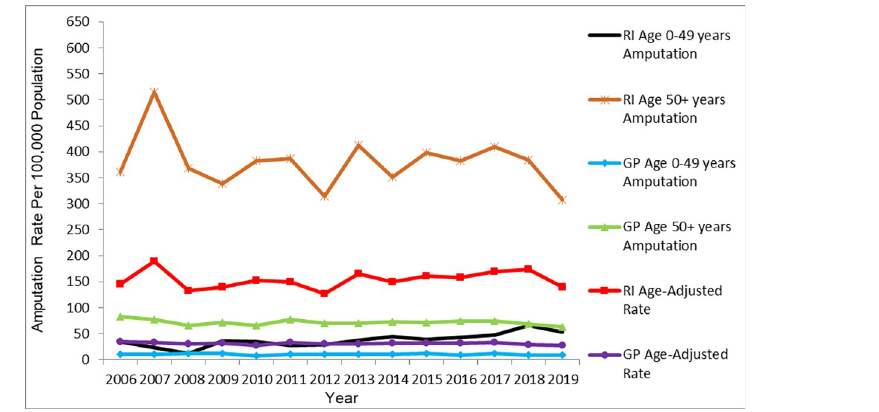
Fig 4. RI and GP age-adjusted and age-stratified crude amputation rates by year.